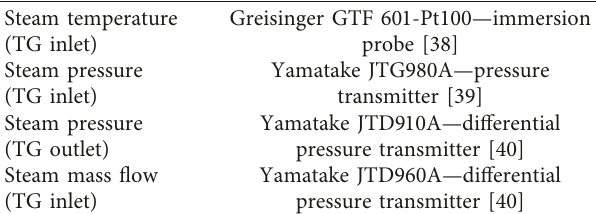
Table 3: Measuring equipment for the TG steam